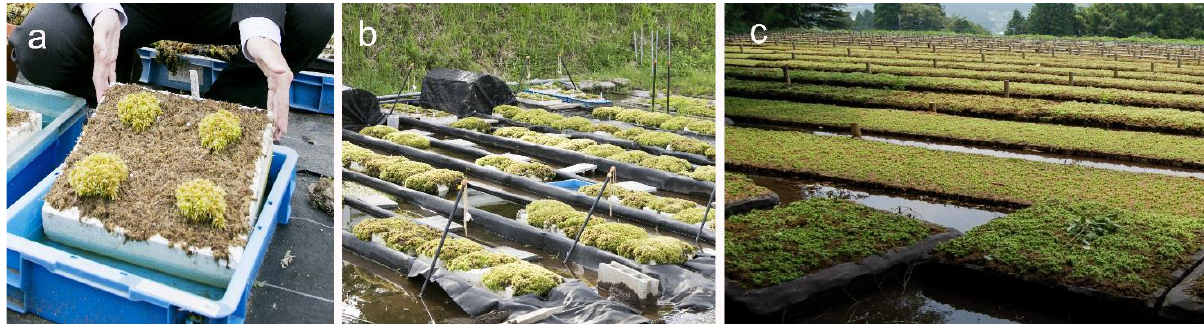
Figure 8. Sphagnum culture of (a) floating raft, (b) experimental site and (c) large scale performance on rice field at MA (Mount